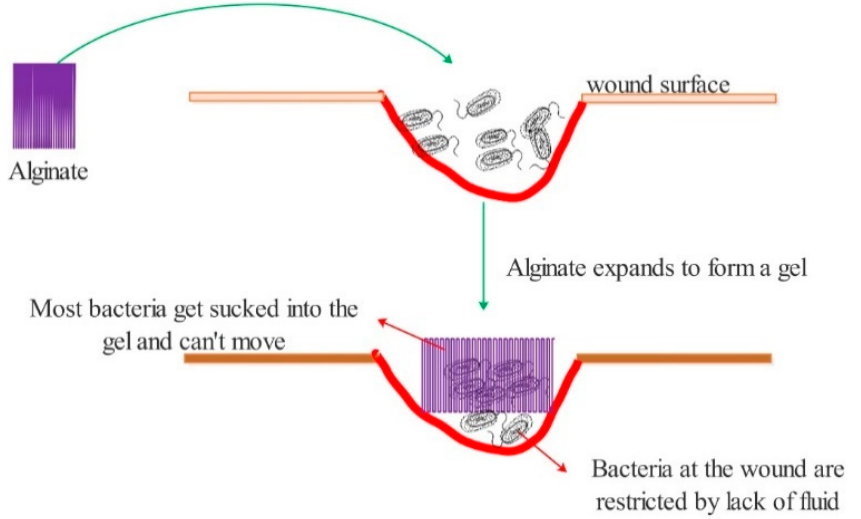
Figure 4. Two different antibacterial mechanisms of alginates.